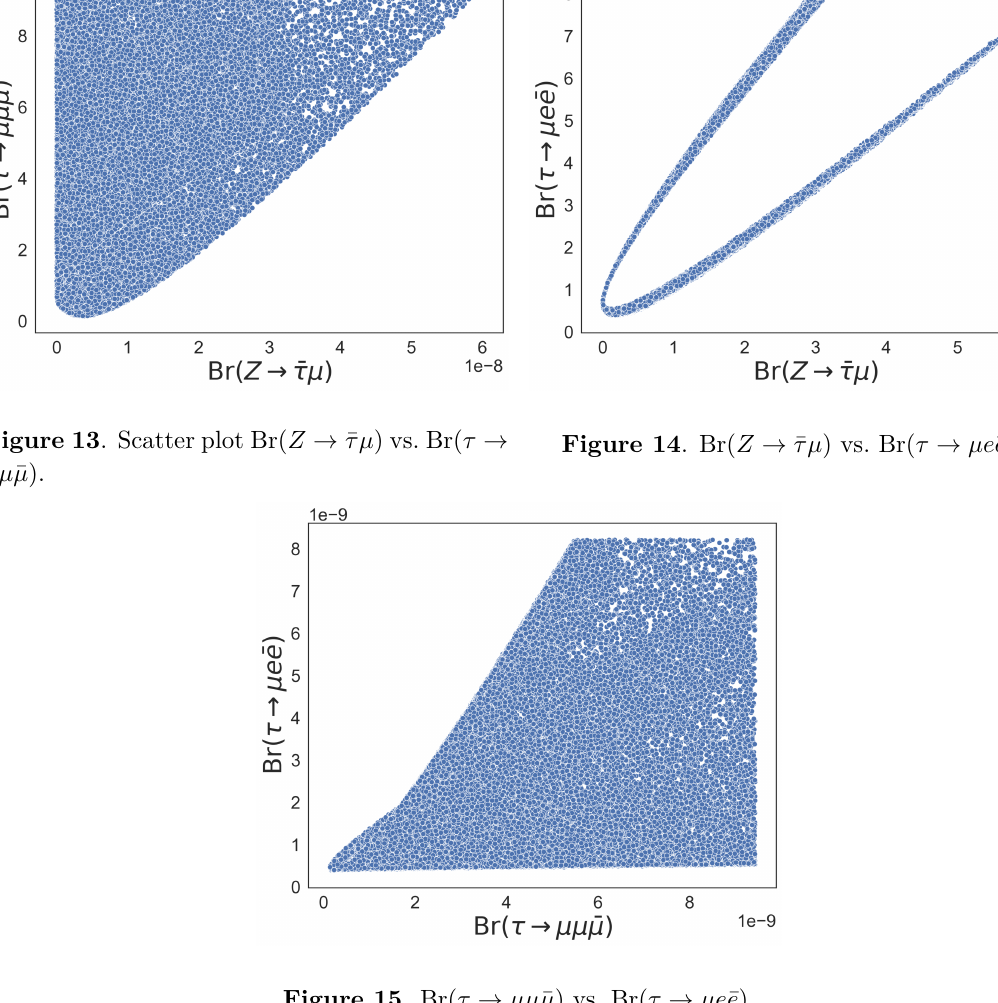
Figure 15 . Br( τ → µµ ¯ µ ) vs. Br( τ → µe ¯ e )